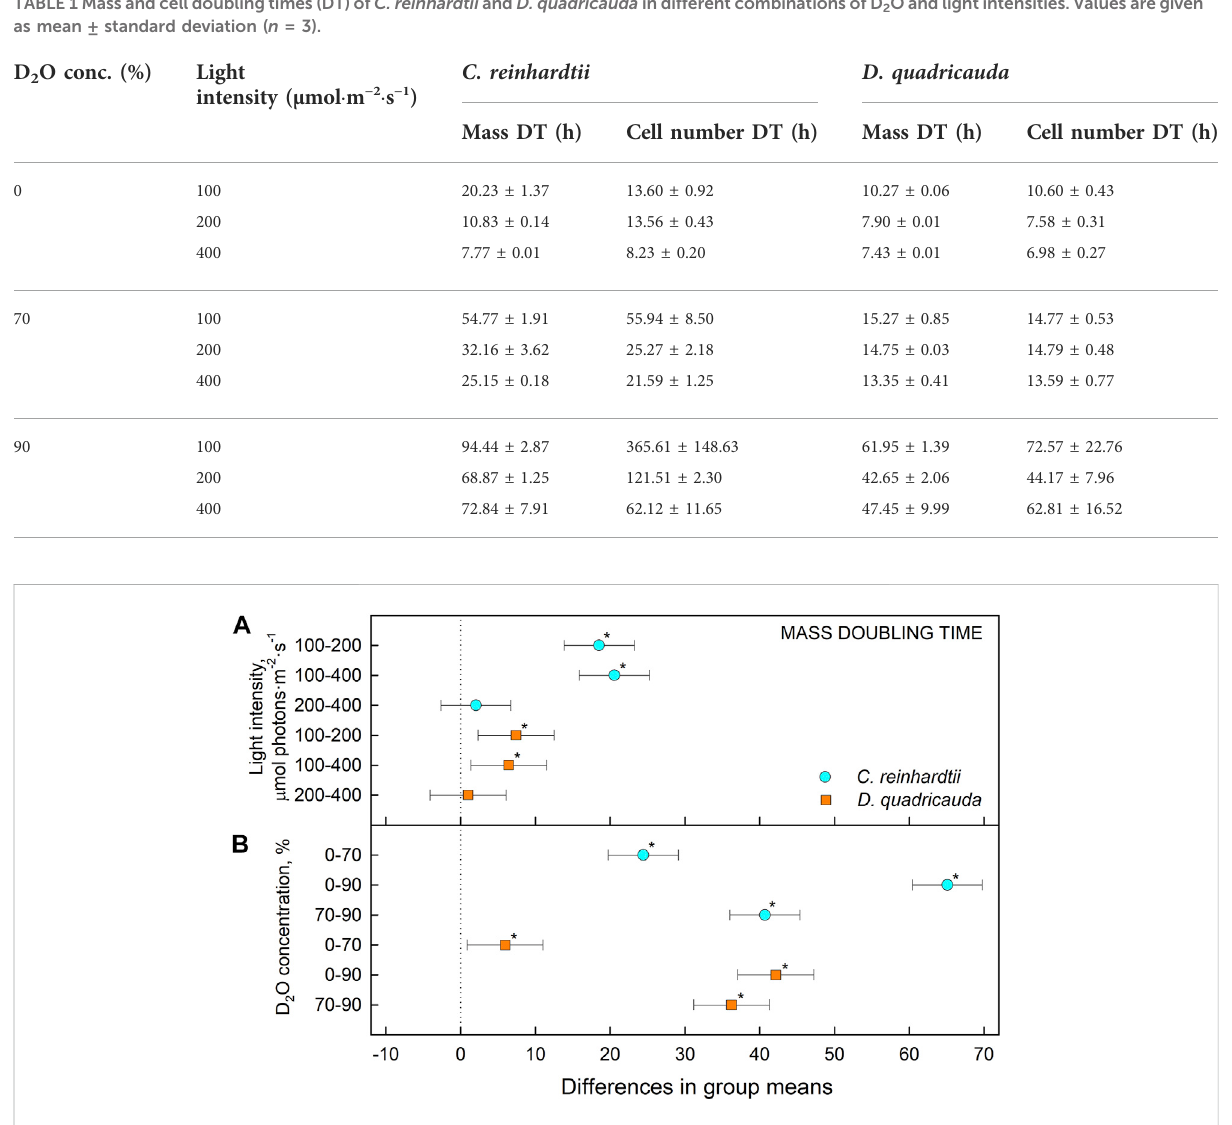
FIGURE 4 Tukey ’ s HSD test of mass doubling times plotted as 95% con fi dence intervals of mean difference between groups indicated on the left. The effect oflightintensity (A) andthe effect ofD 2 O concentration (B) on mass doubling times of C.reinhardtii (cyan circles) and D.quadricauda (orange squares) are plotted separately. A difference in group means (X axis) equal to zero indicates that the group means are equal, so only a con fi dence interval that does not contain zero is statistically signi fi cant ( p = 0.05, indicated by an